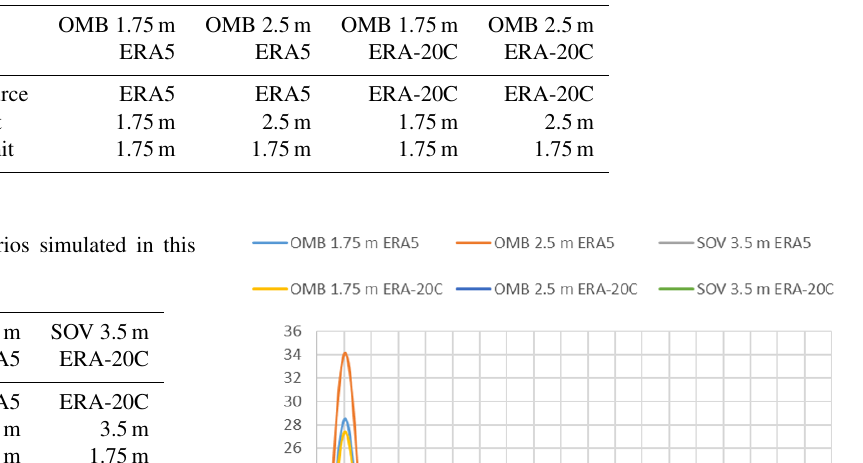
Table 3. Characteristics of the OMB scenarios simulated in this study.